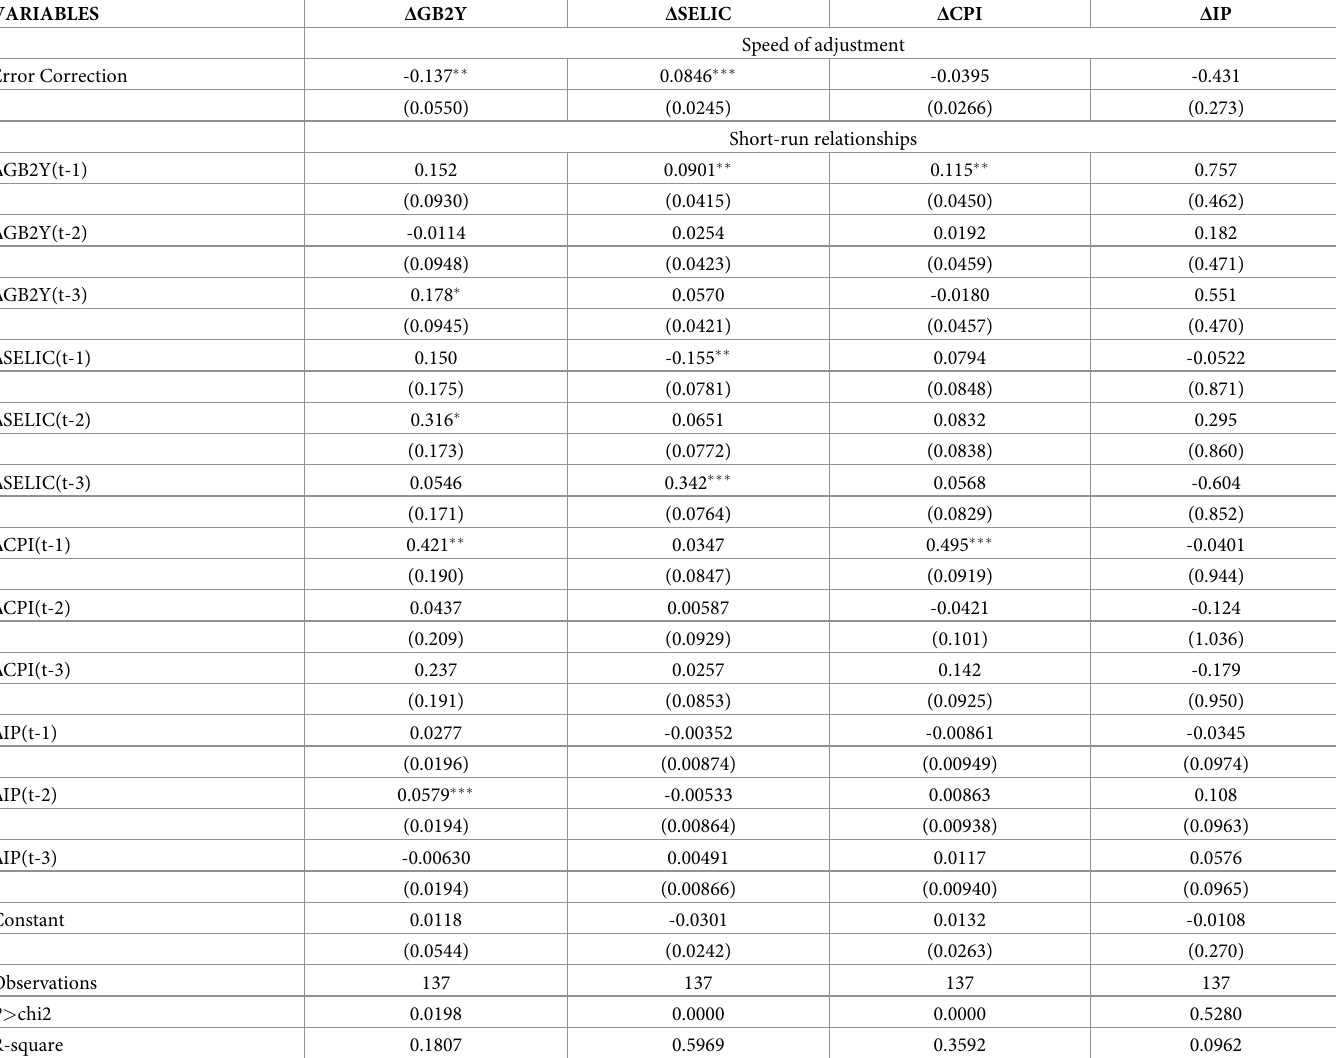
Table 7. Speed of adjustment and short-run relationship from VECM for Eq